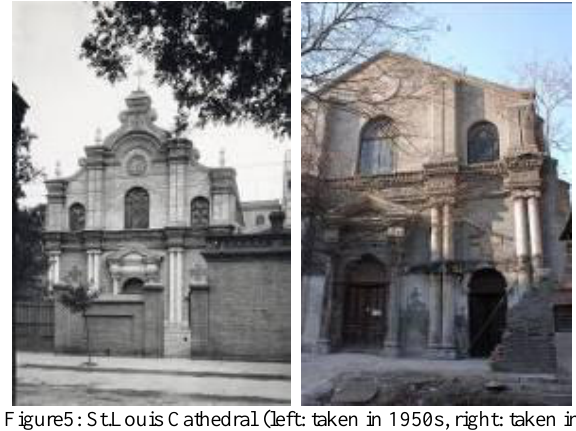
Figure5: St.Louis Cathedral (left: taken in 1950s, right: taken in 2008 )